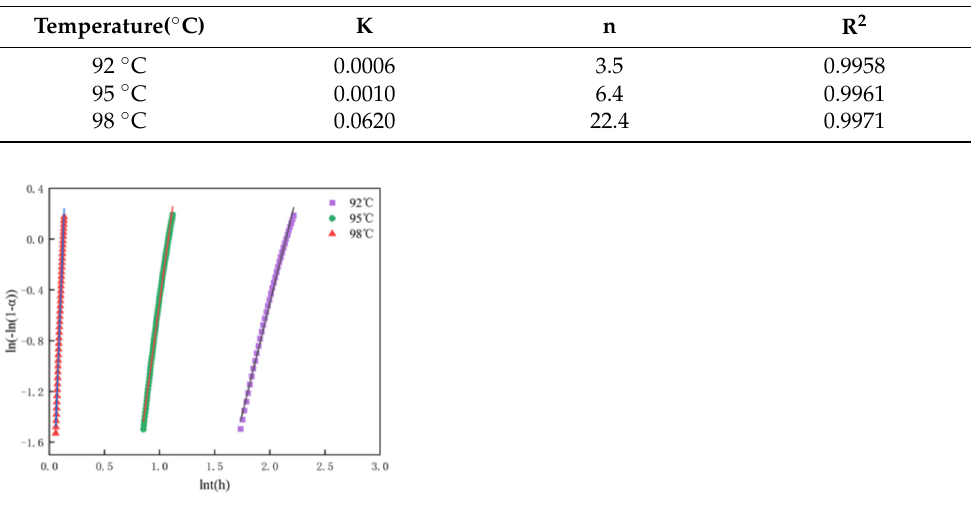
Figure 4. The plot of ln ( − ln (1 − α )) vs. ln ( t ) for α -HH sample synthesized via hydrothermal method. Figure 4 . The plot of ln ( − ln (1 −α )) vs. ln (t) for α -HH sample synthesized via hydrothermal meth- od.